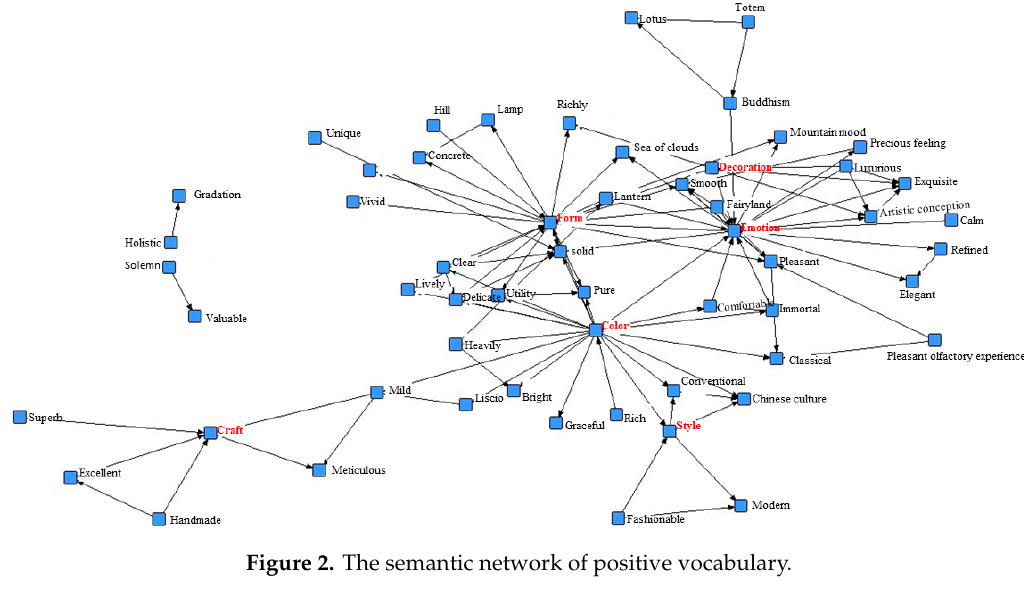
Soc. Sci. 2020 , 9 , x Figure 2. The semantic network of positive vocabulary. Figure 2. The semantic network of positive vocabulary.